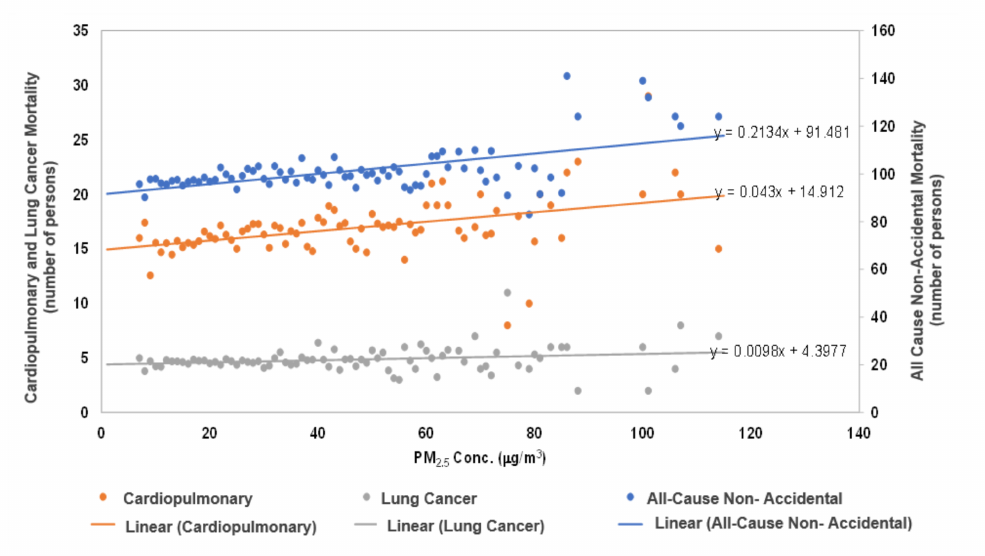
Figure 6. Relationship between All-Cause Non-Accidental, Cardiopulmonary, and Lung Cancer Mortalities and PM 2.5 concentrations in